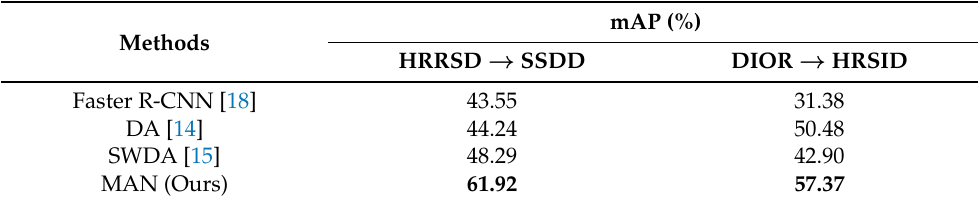
Table 5. Comparison of SAR ship detection performance (mAP) on different cross-domain ship detection datasets. The best results are indicated by bold.